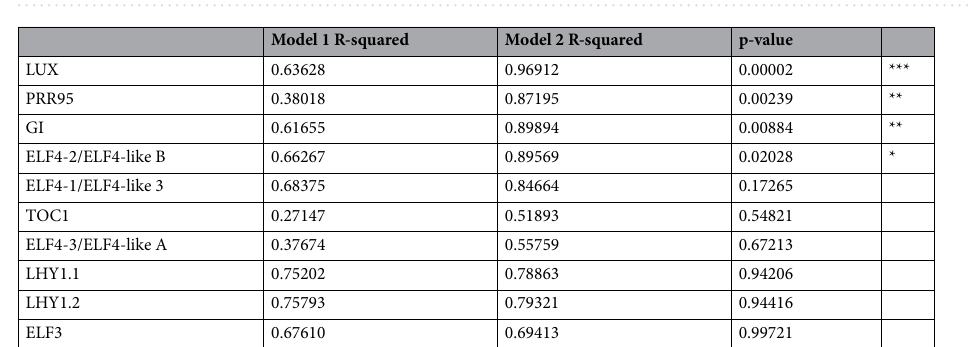
Figure 4. Relative mean expression of Brachypodium GI ( a ), PRR95 ( b ), LUX ( c ) and ELF4-like B ( d ) genes in roots and shoots under three different lighting regime and two different kinds of soil water content. Mean transcript levels were calculated from overall relative transcript amounts of the target gene monitored by qRT-PCR every 4 h over a 76-h long time course experiment in total aerial parts (shoot) and total roots (root) of 4-week-old Brachypodium distachyon plants grown under two watering conditions [80% soil water content (80) and 40% soil water content (40)] and three lighting regimes [(18:6 light: dark (18:6 LD), 24:0 light (24:0 LL) and 0:24 dark (24:0 DD)]. Mean transcript levels were normalized to mean transcript level of shoots under 18:6 LD conditions and 80% soil water content. Plants were entrained for 4 weeks in 18:6 light: dark cycles before releasing them in the three different lighting regimes. As regards water status, plants were grown with 80% soil water content for 2 weeks before being subjected to modest water deprivation (40% soil water content) for 2 weeks before sampling. Error bars are ± SD for two independent experiments. Statistical analyses were performed by linear regression model and by linear regression supplemented with interacting prediction of the three different interactors: lighting regime, water status and plant part. Statistical testing of the models is summarized in Table 3. Values are statistically different (p < 0.05 by ANOVA) if interaction between the parameters is predicted. This figure presents genes with significant interaction. Relative mean expression values of BdLHY1.1, BdLHY1.2, TOC1, ELF3, ELF4-like 3 and ELF4-like A can be found in Supplementary Fig. S2.